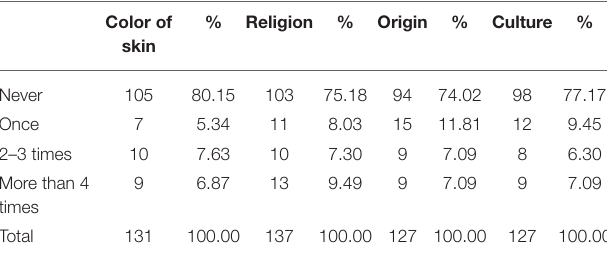
TABLE 3 | Proportion of perpetrators reporting a specific search for hateful